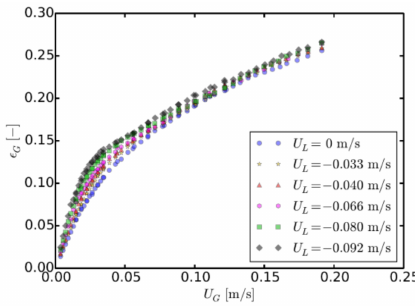
Figure 16. Pipe sparger in open tube configuration—data from ref. [34].